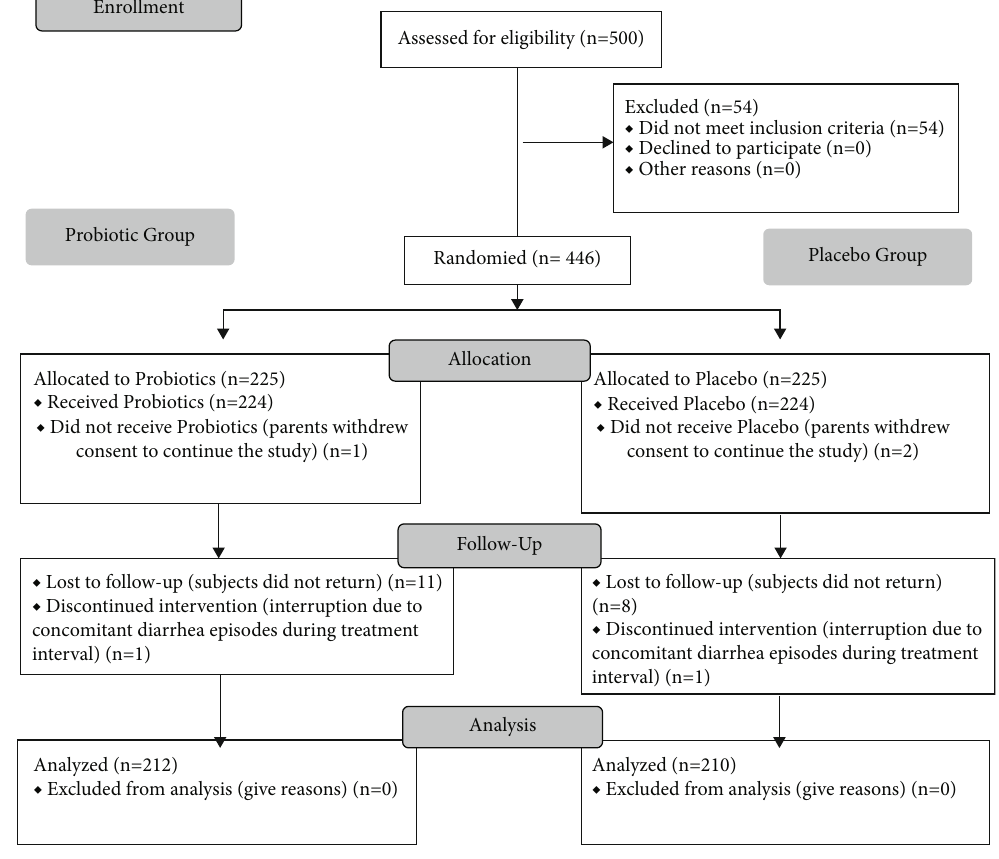
Figure 1: CONSORT fl